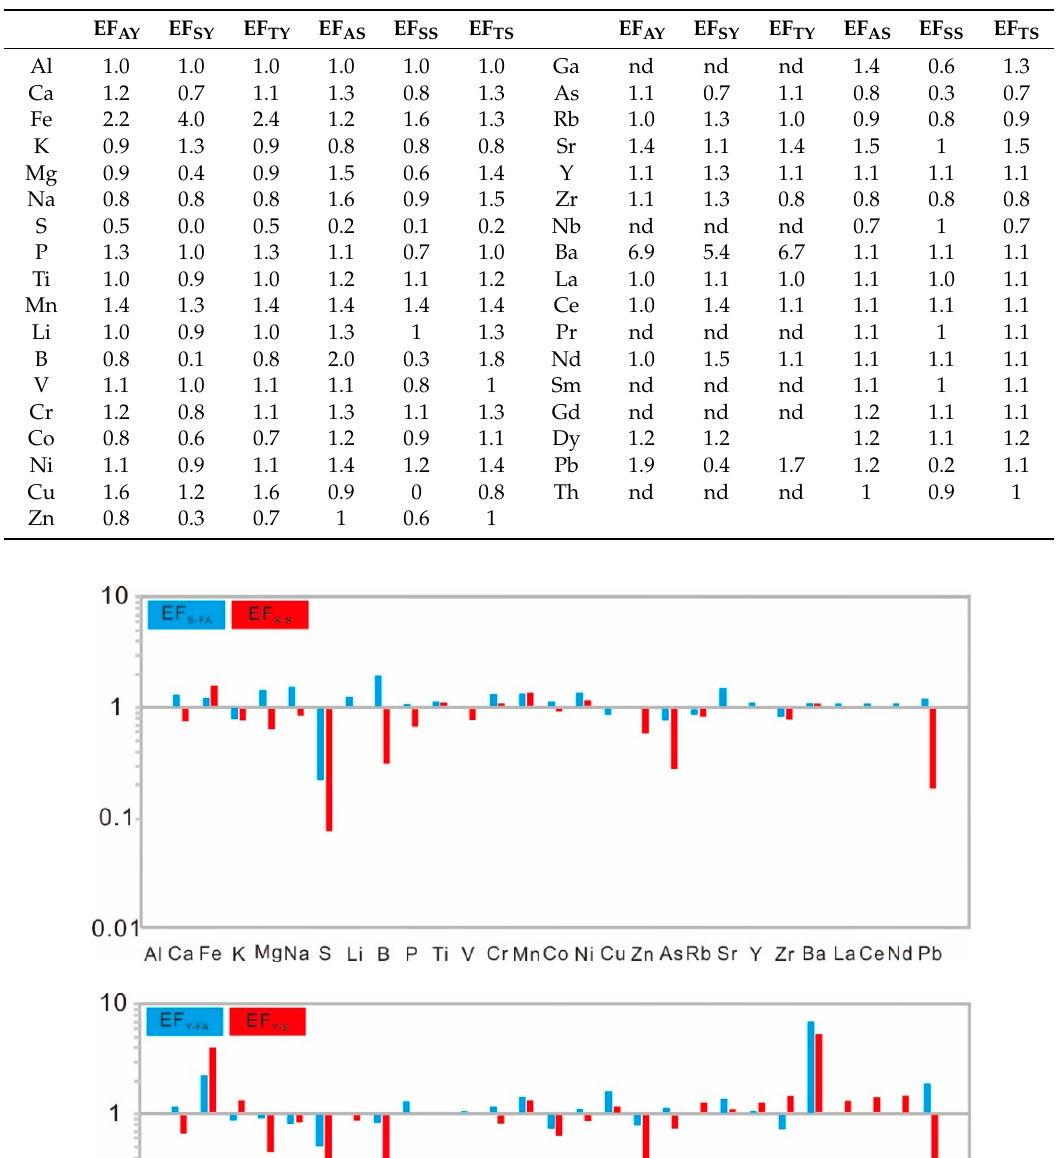
Table 5. Enrichment factors (EF) and total enrichment factors (EF T ) of major and trace elements for Shenhuo power plants and Yihua power plants. EF AS , EF AY enrichment factor in fly ash from Shenhuo power plant and Yihua power plant respectively; EF SS , EF SY enrichment factor in slag from Shenhuo power plant and Yihua power plant respectively; EF TS , EF TY total enrichment factors of major and trace elements for Shenhuo power plants and Yihua power plant respectively.